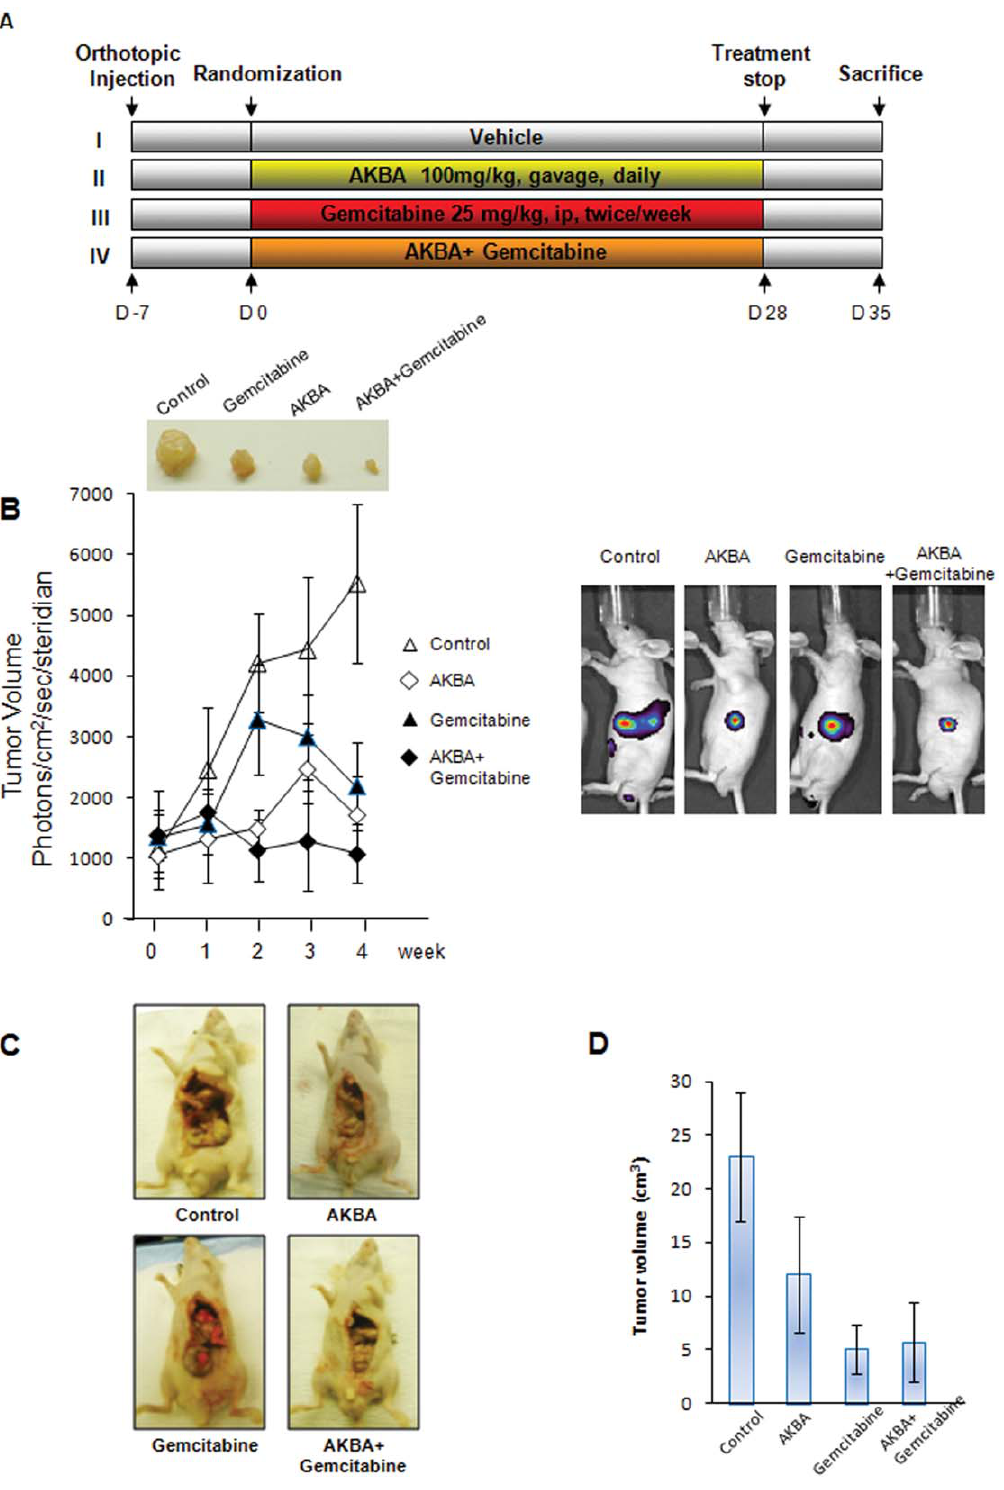
Figure 2. AKBA potentiates the effect of gemcitabine in blocking the growth of pancreatic cancer in nude mice. A, schematic of experimental protocol described in Materials and Methods. Group I was given corn oil (100 m L, p.o., daily), group II was given AKBA (100 mg/kg, p.o., daily), group III was given gemcitabine (25 mg/kg, i.p., twice weekly), and group IV was given AKBA (100 mg/kg, p.o., daily) and gemcitabine (25 mg/ kg, i.p., twice weekly; n=5). B, bioluminescence IVIS images of orthotopically implanted pancreatic tumors in live, anesthetized mice and measurements of photons per second depicting tumor volume at various time points using live IVIS imaging at the indicated times (n=5). Points, mean; bars, SEM. C, Necropsy photographs of mice. D, tumor volumes in mice measured on the last day of the experiment at autopsy with Vernier calipers and calculated using the formula V=2/3 p r 3 (n=5). Columns, mean; bars, SE.